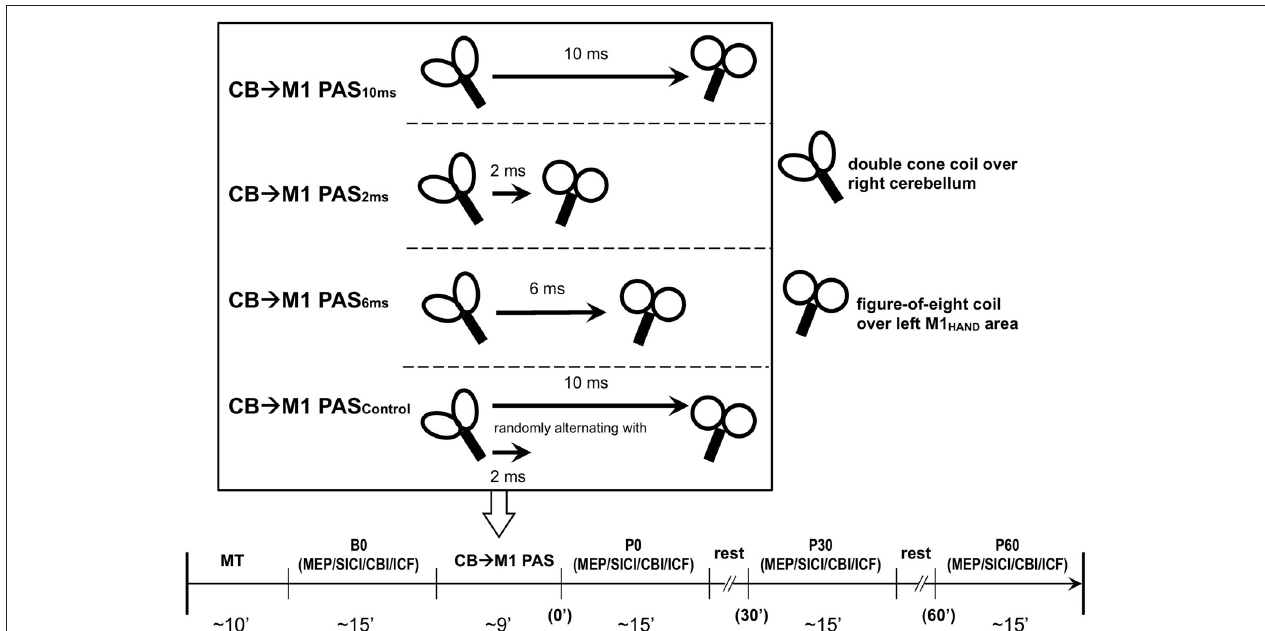
PAS Control (randomly alternating intervals of 2 and 10ms). The timeline in the lower part of the diagram shows the order of measurements and their approximate durations (in min) before (B0) and after CB → M1 PAS (P0, P30, and P60: immediately and 30 and 60min post-PAS). Abbreviations: MT, motor threshold; MEP, motor-evoked potential; SICI, short-interval intracortical inhibition; CBI, cerebellar-motor cortex inhibition; ICF, intracortical